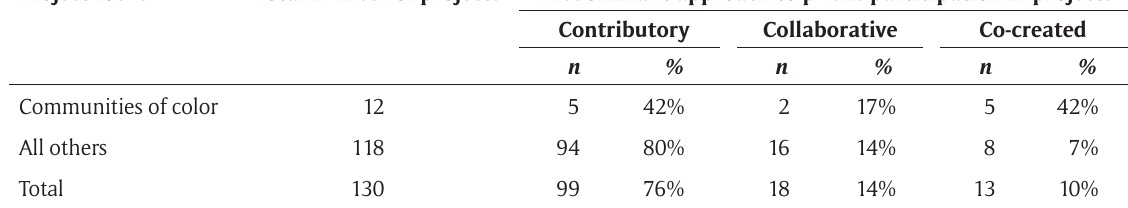
Table 1: Forms of participation in environmental citizen science projects in northern California with a focus on communities of color compared with all projects surveyed. Reproduced with permission from Ballard and Dixon